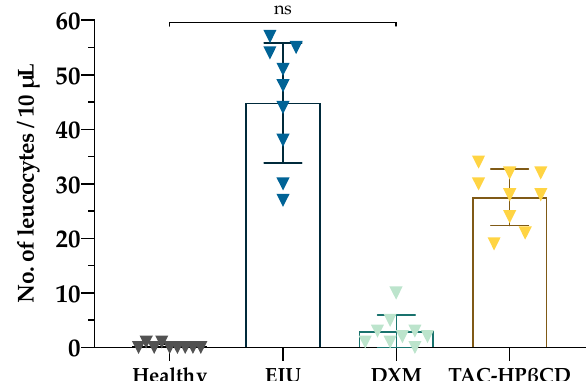
Figure 4. Quantitative analysis of leucocytes in aqueous humor. Groups were healthy eyes (Healthy), EIU untreated rats (EIU), EIU rats treated with dexamethasone (DXM) and EIU rats treated with TAC ‐ HP β CD (TAC ‐ HP β CD) ( n = 3 eyes per group measured in triplicate). Bars represent mean ± SD. There are statistically significant differences among all groups except between Healthy and DXM group whose difference is non-significant